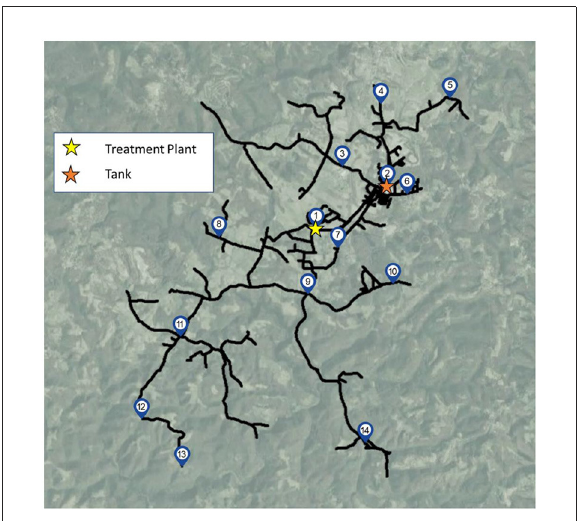
FIGURE1 Sampling sites including the treatment plant (site 1), storage tank (site 2) and 12 additional sites throughout the distribution